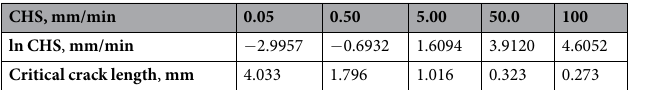
Table 2. Critical crack length of blunt notched HDPE at various crosshead